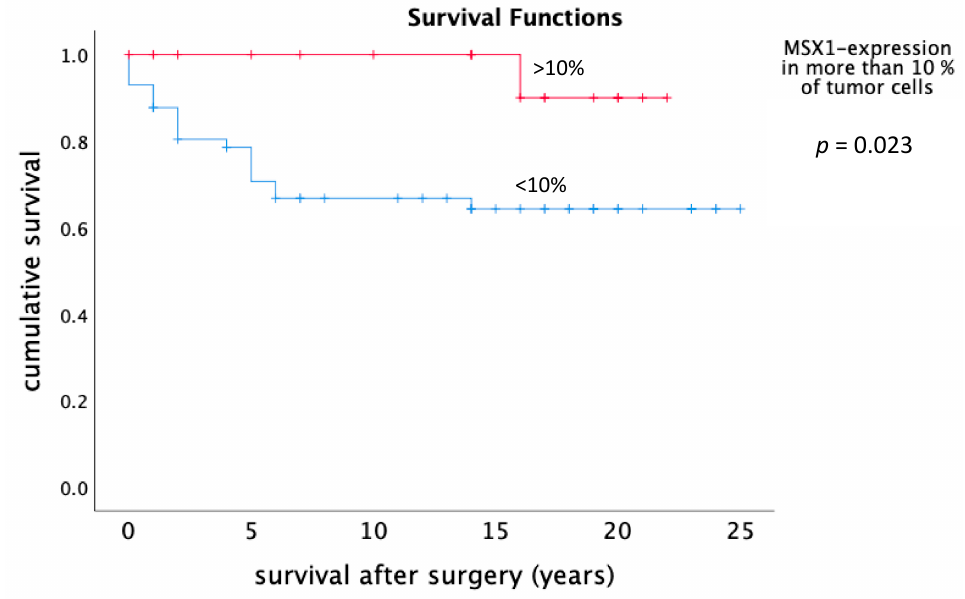
Figure 5. Survival of patients with MSX1-expression in more than 10% of the tumor cells and less than 10% MSX-1 expression or no expression.